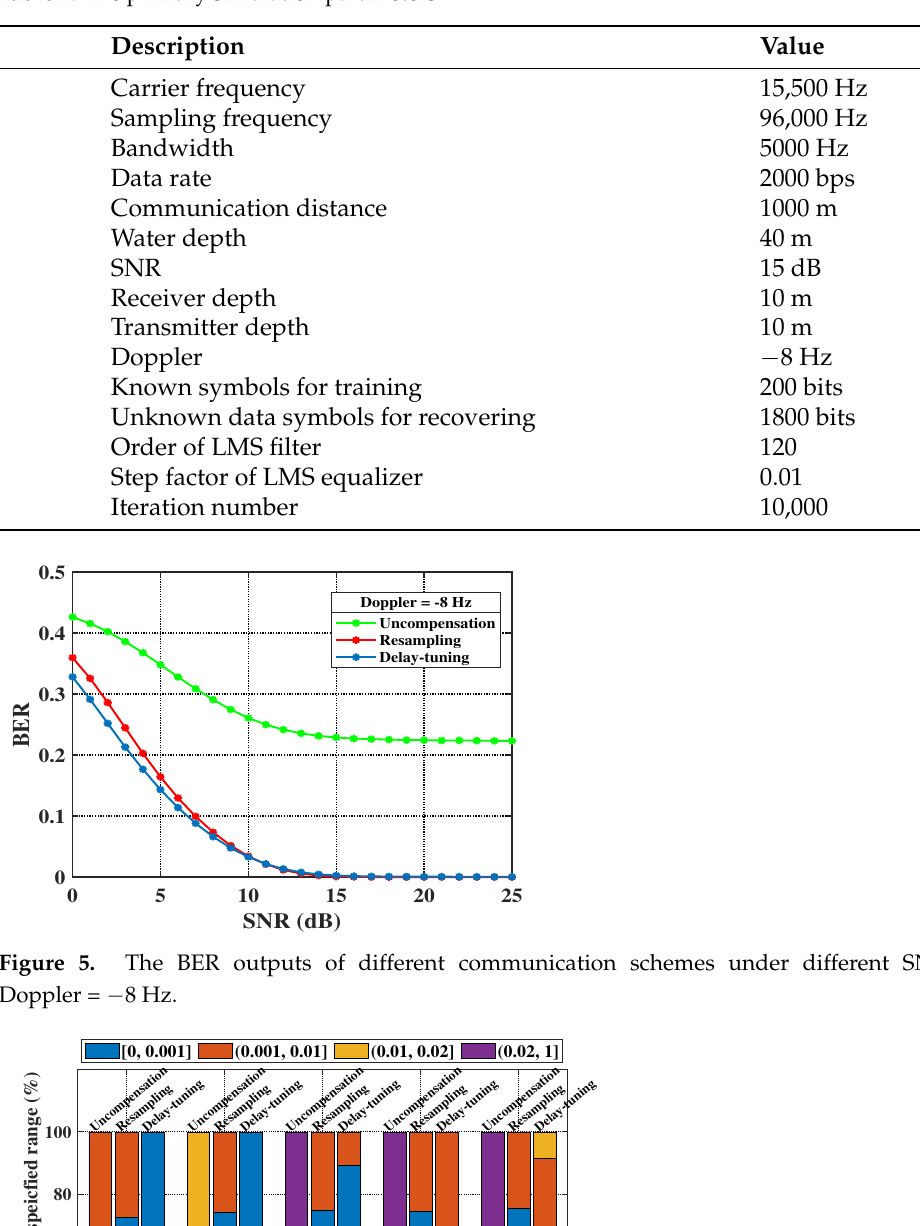
Table 1. The primary simulation parameters.